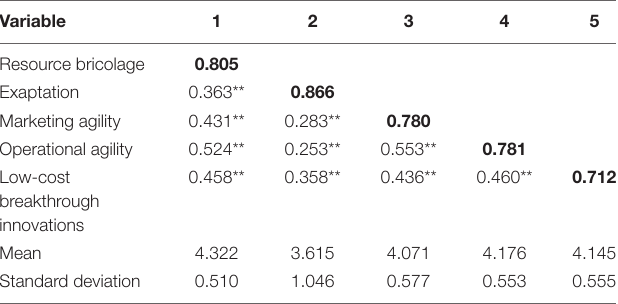
TABLE 2 | Mean, standard deviation, and correlation coefficient.